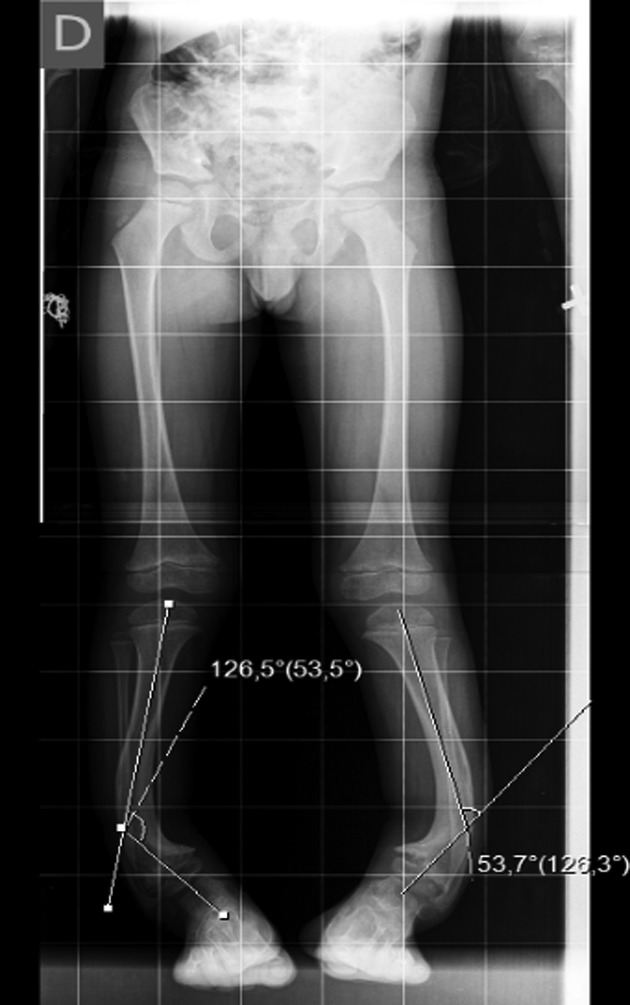
Preoperative Rx.